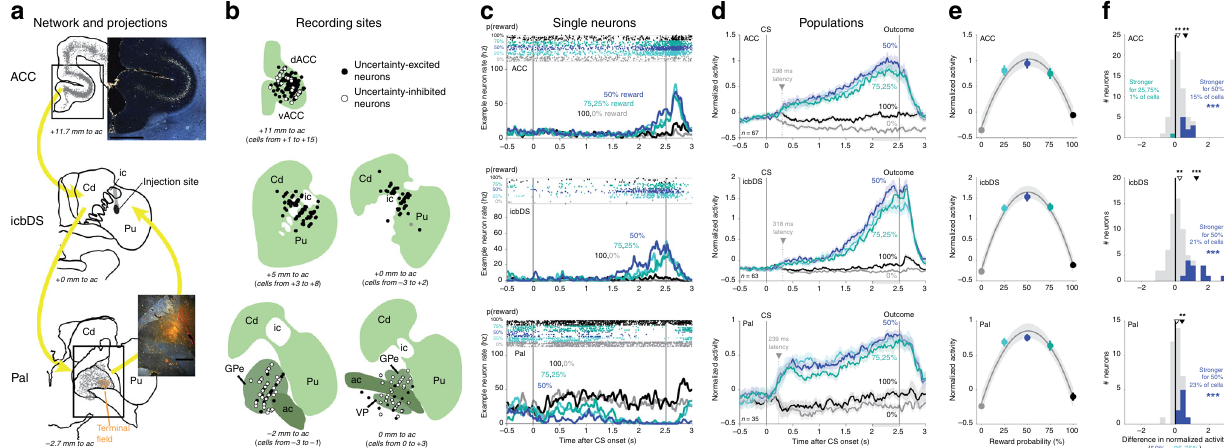
Fig. 1 A cortico-basal ganglia network signals reward uncertainty. a ACC – icbDS – Pal network. Lucifer yellow was injected in icbDS (middle, black area). Retrogradely labeled cell bodies (gray) were found in ACC (top; inset) and Pal (bottom). Anterogradely labeled fi bers (orange area) were found in Pal (bottom; inset). ic: internal capsule, Cd: caudate nucleus, Pu: putamen, dACC: dorsal ACC, Pal: pallidum, vACC: ventral ACC, ac: anterior commissure, GPe: globus pallidus external segment, VP: ventral pallidum. Text indicates the plane ’ s anterior-posterior position relative to the midline anterior commissure. Scale bar: 2 mm. b Reconstruction of recording sites. Circles indicate locations of neurons that responded to uncertainty with signi fi cant excitation (black) or inhibition (white). Structures are shown in the coronal plane. Neurons are projected onto the nearest shown plane; text indicates the range of neuron locations. c Example neurons in each area. The neurons have excitatory or inhibitory ramping activity up to the time of uncertain reward: strongest for highly uncertain rewards (blue, 50%), strong for intermediately uncertain rewards (turquoise colors, 25 and 75%), and weak for certain outcomes (black, 100%; gray, 0%). Top: spike times (dots) on each trial (rows). Bottom: smoothed fi ring rates. d Population average normalized activity of uncertainty coding neurons in each area. Shaded areas are ± 1 SE. Arrow and text indicate latency of uncertainty coding. Gray area below x -axis is the pre-outcome analysis window. e Population average pre-outcome normalized activity is well fi tted with a second-order polynomial function of reward probability (gray lines; shaded areas are ± 1 bootstrap SE) showing the inverted-U relationship with reward probability expected for uncertainty coding. f Graded coding of reward uncertainty. Histograms show each neuron ’ s difference in normalized activity between CSs with high (50%) vs. intermediate (25, 75%) uncertainty. Colored neurons have signi fi cantly differential activity: more normalized activity for high uncertainty (blue) or intermediate uncertainty (turquoise). *** indicates more neurons than expected by chance ( p ≤ 0.001, binomial test). Arrows indicate means of all neurons (open arrow) and all neurons with signi fi cant differential activity ( fi lled arrows); **, *** indicate the signi fi cance of their difference from zero, p < 0.01, 0.001 (signed-rank